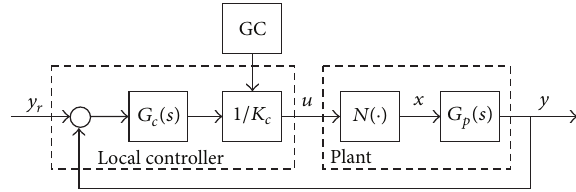
Figure 7: Multilinear model based control